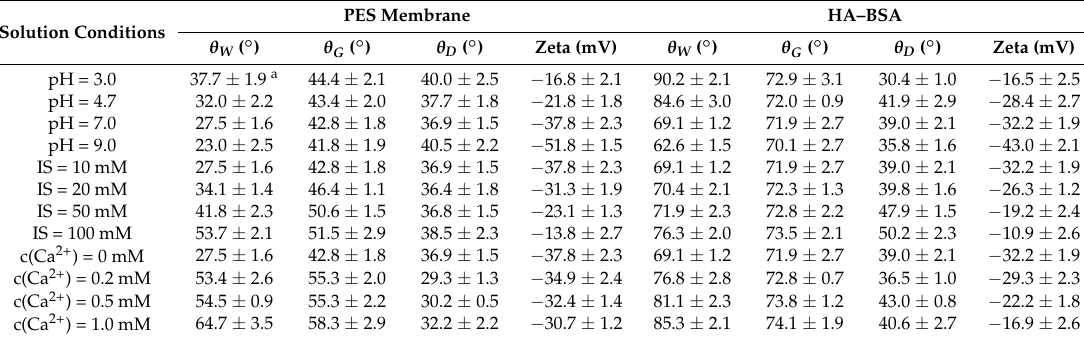
Table 1. Contact angles and zeta potentials of the polyethersulfone (PES) membrane and humic acid (HA)–bovine serum albumin (BSA) mixtures at different solution conditions. Solution